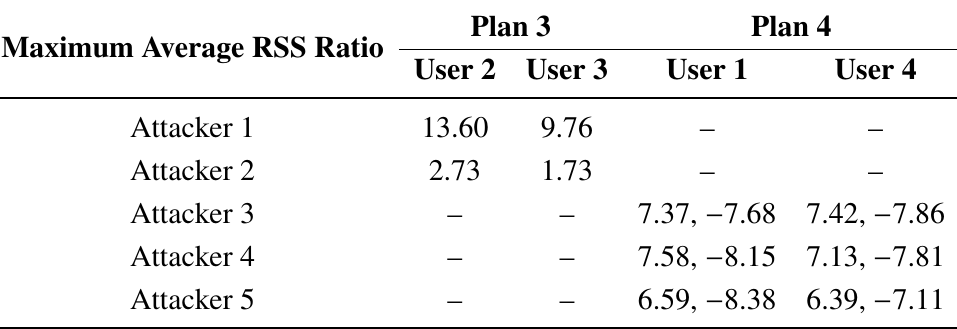
Table 5. Results of Plans 3 and 4.